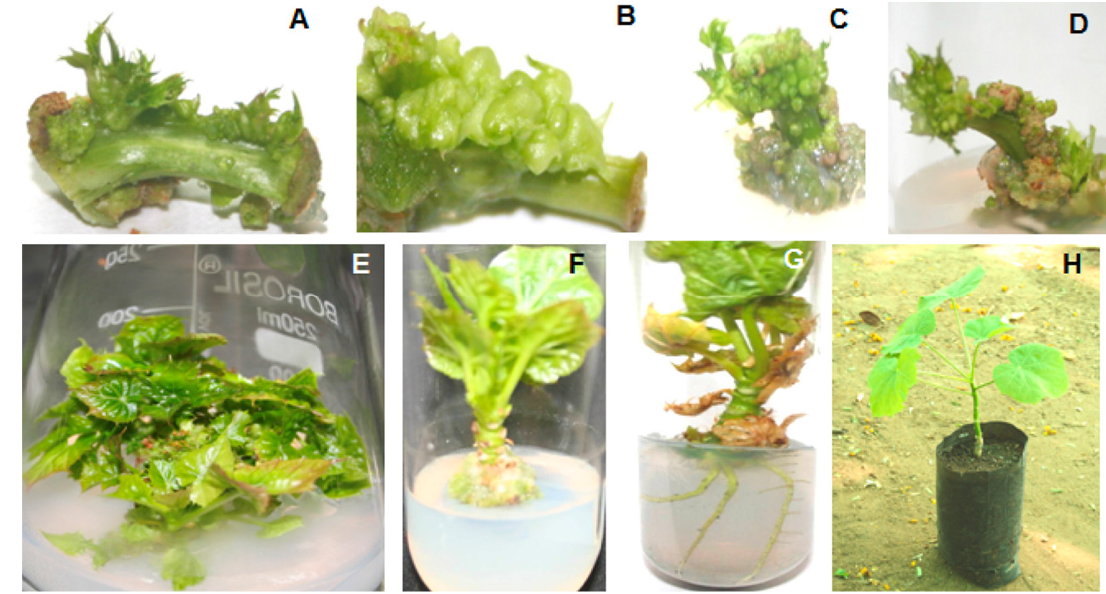
Figure 1. Direct organogenesis of jatropha from petiole explants. ( A ) in vitro petiole in horizontal position, ( B ) in vivo petiole in horizontal position, ( C ) in vitro petiole in vertical position and ( D ) in vivo petiole in vertical position on MS medium supplemented with 2.27 µ M TDZ. ( E ) Shoot proliferation of induced shoot buds on MS medium supplemented with 10 µ M KN + 4.5 µ M BAP + 5.5 µ M NAA. ( F ) Elongation of proliferated shoot on MS medium supplemented with 2.25 µ M BAP and 8.5 µ M IAA. ( G ) Development of roots at the base of elongated shoot on half strength of MS medium sup- plemented with 5 µ M IBA + 5.7 µ M IAA + 11.0 µ M NAA after 4 weeks. ( H ) Regenerated plant